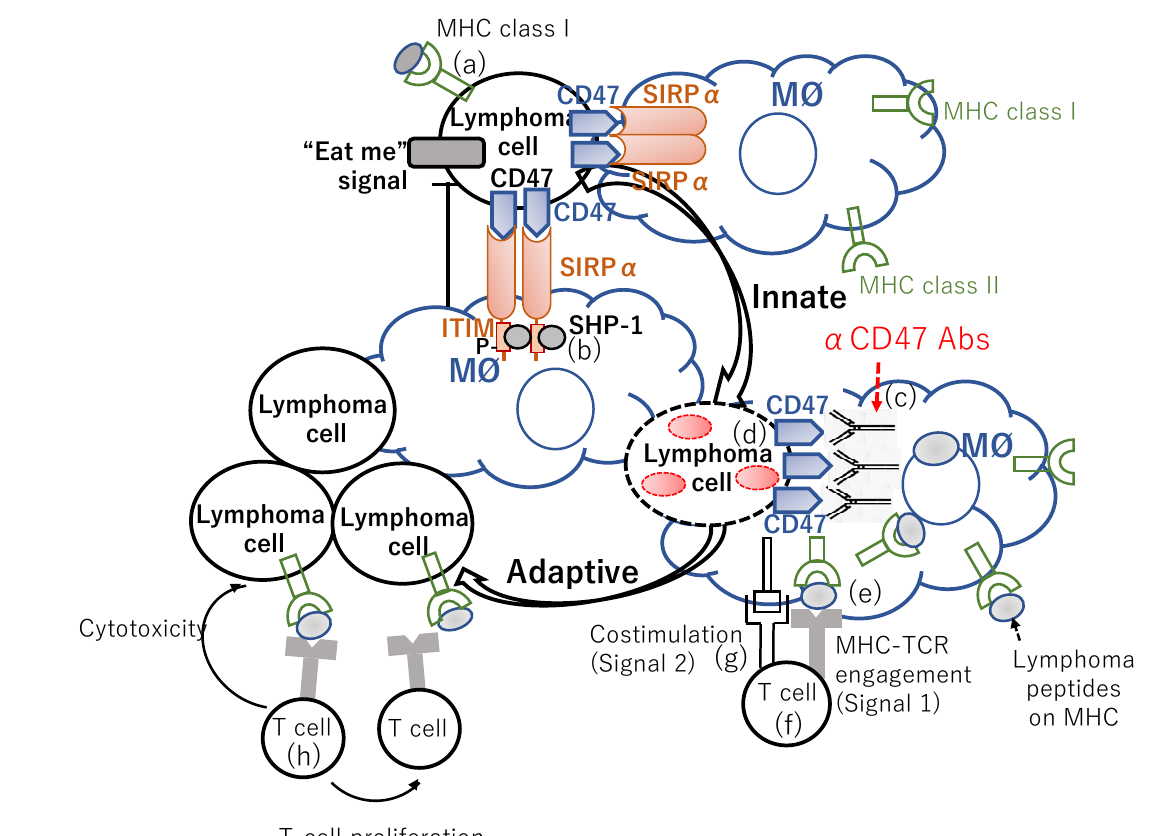
Figure 2. Lymphoma cells express MHC class I ( a ), surface markers of “self,” antiphagocytic (“don’t eat me,”) and phagocytic (“eat me”) signals. Engagement of CD47 (i.e., “don’t eat me” signal) on lymphoma cells with SIRP α on macrophages causes activation and phosphorylation of SIRP α ITIM motifs and the recruitment of SHP-1 phosphatases ( b ) preventing myosin-IIA accumulation at the phagocytic synapse, which results in inhibiting lymphoma cell phagocytosis. Blocking the CD47:SIRP α engagement with anti-CD47 antibodies ( c ) leads to an increase in lymphoma cell